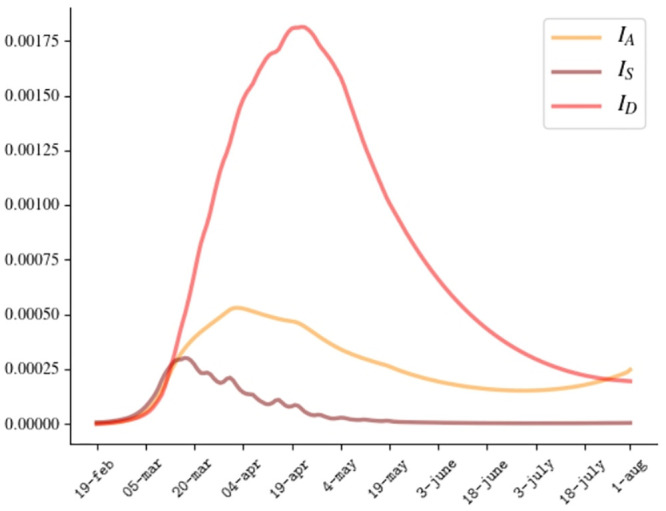
Franction of active cases IA, IS, ID.